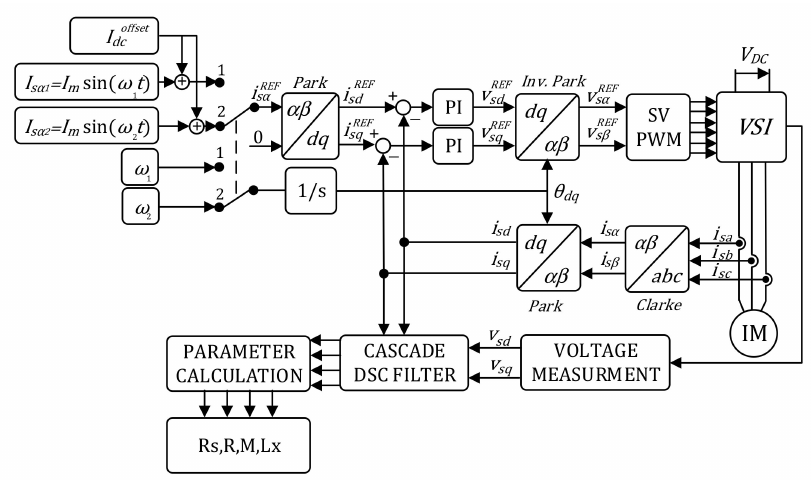
Figure 12. Experimental configuration for the implementation of the technique with two sinusoidal current test signals.